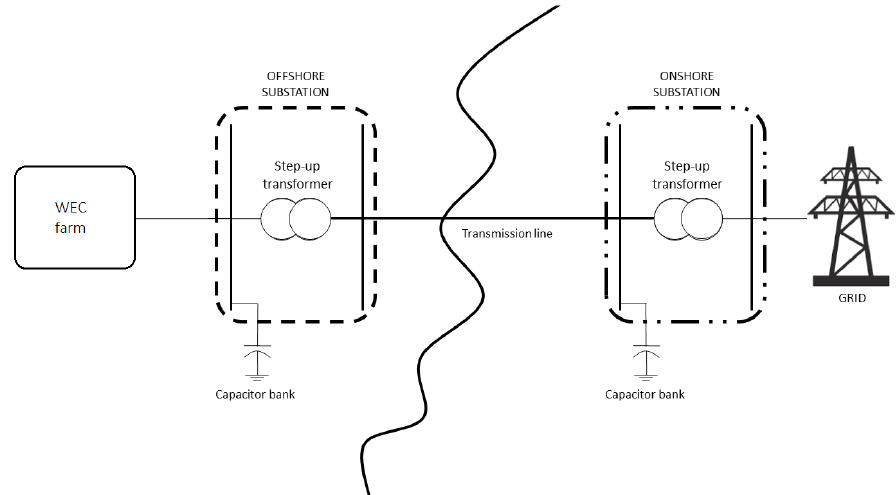
Figure 33. Diagram of the energy transport from the offshore WEC farms to the grid, including different